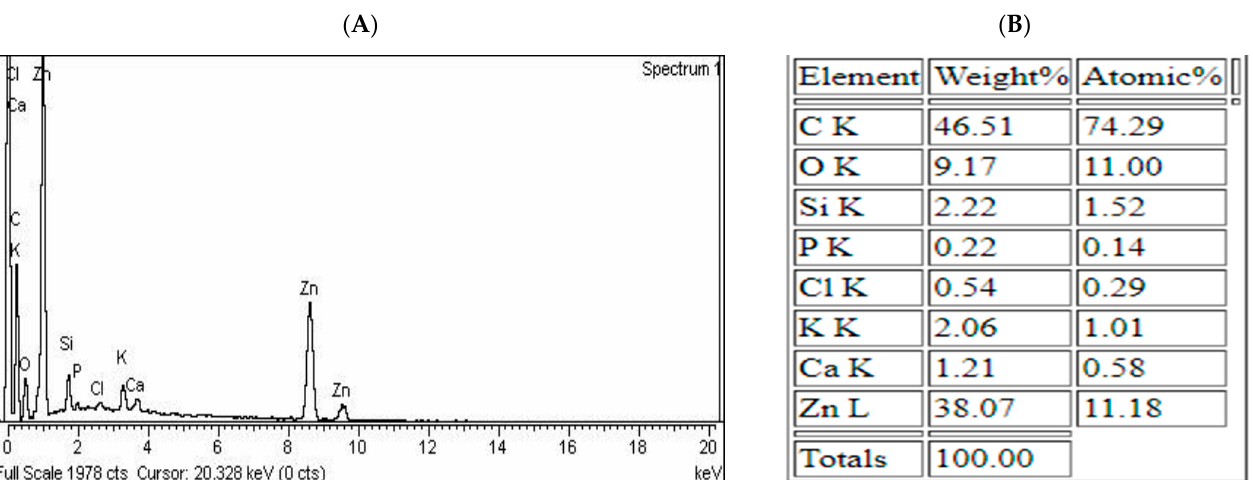
Figure 2. EDX spectra ( A ) and elemental analysis of MB-ZnO nanocomposites ( B ).